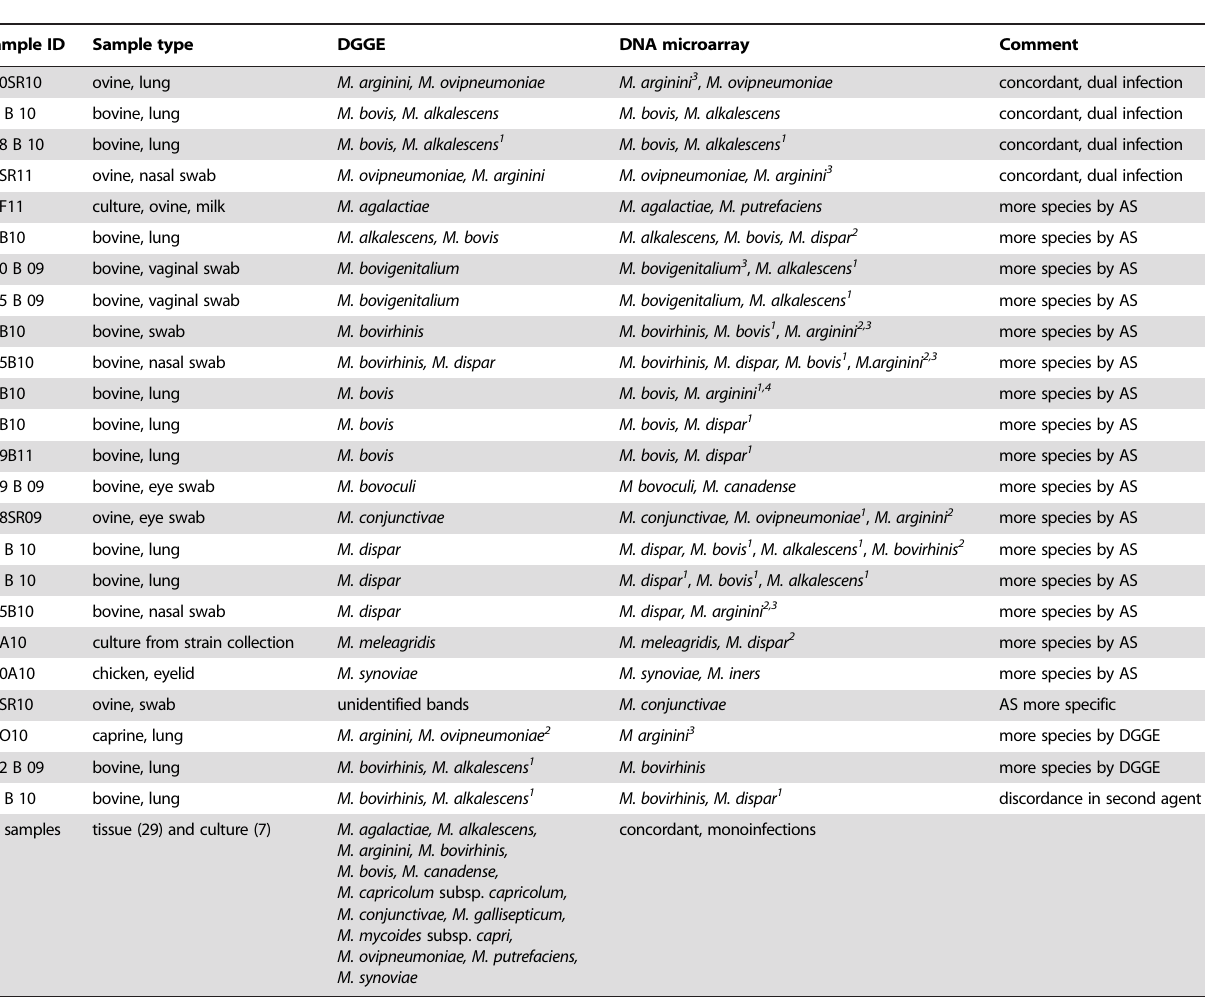
Table 2. Summary of test results of DNA microarray and DGGE assays on 51 clinical tissue samples and 9 cultures from field